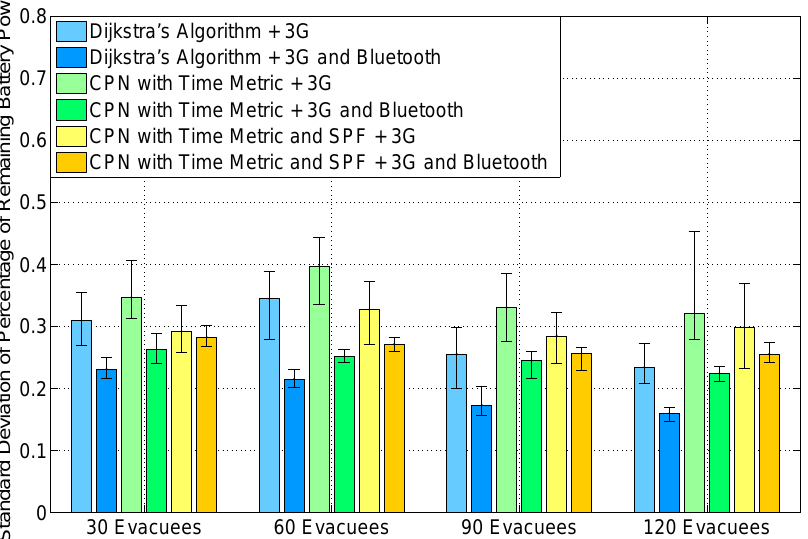
Figure 5. The average standard deviation of the percentage of remaining battery power of smart phones in five simulation runs. The error bars represent the min/max value of the standard deviation found in the five